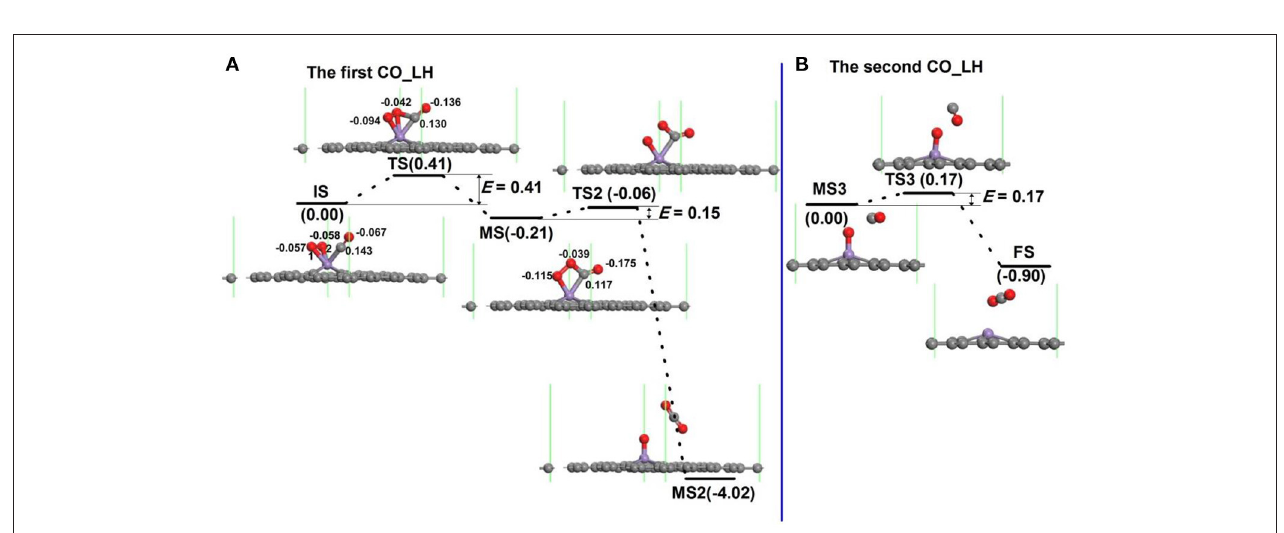
FIGURE 6 | The reaction pathway of CO oxidation on Mn-embedded graphene for LH mechanism: production of the first CO 2 molecule (A) , and the second CO 2 moelcule (B) . The energy profile for the formation of CO 2 molecule is also shown. The unit of E is eV, where E is the energy barrier. The Hirshfeld charge near the adsorbate is also